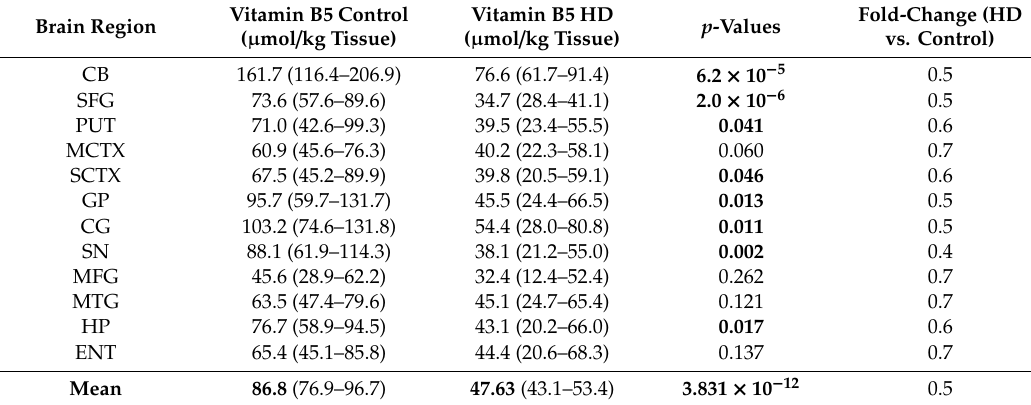
Table 2. Vitamin B5 concentration levels in controls and HD cases. Table illustrating the mean ( ± 95% CI) values of vitamin B5 concentration for each brain area analysed in controls and HD gene-carriers. The overall mean of vitamin B5 concentration across all the brain areas is also reported in the table. Concentration values have been expressed as µ mol / kg brain tissue. Multiple two-tailed t -tests were used and p -values < 0.05 were considered significant. Vitamin B5 fold-changes between HD versus controls are included in the